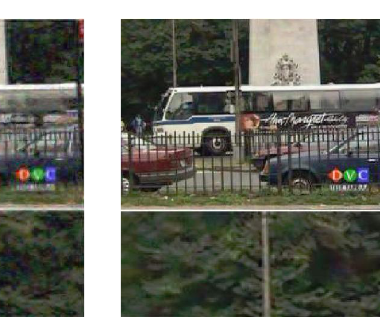
(J)FIG. 5(a). ORIGINAL IMAGE FIG. 5(b). NOISY IMAGE WITH SIGMA=15 FIG. 5(c). NLM (CPSNR=30.64 DB) FIG. 5(d). V-BM3D (CPSNR=30.55 DB)